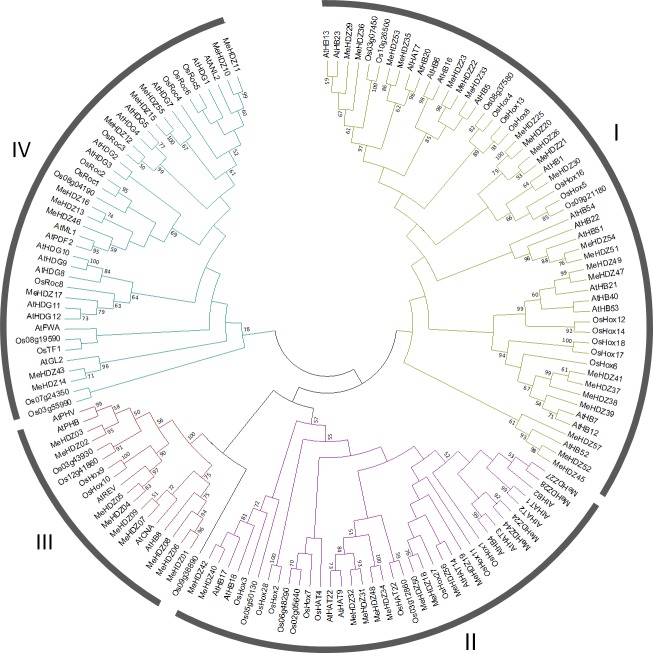
Phylogenetic clustering of HD-Zip proteins from Arabidopsis, rice and cassava.The unrooted phylogenetic tree was constructed by Maximum-Likelihood method with 1000 bootstrap replicates. The HD-Zip protein sequences corresponding to 44 from rice (prefixed with ‘Os’), 48 from Arabidopsis (prefixed with ‘At’), and 57 from cassava (prefixed with ‘Me’) were well separated into four major groups (I-IV).